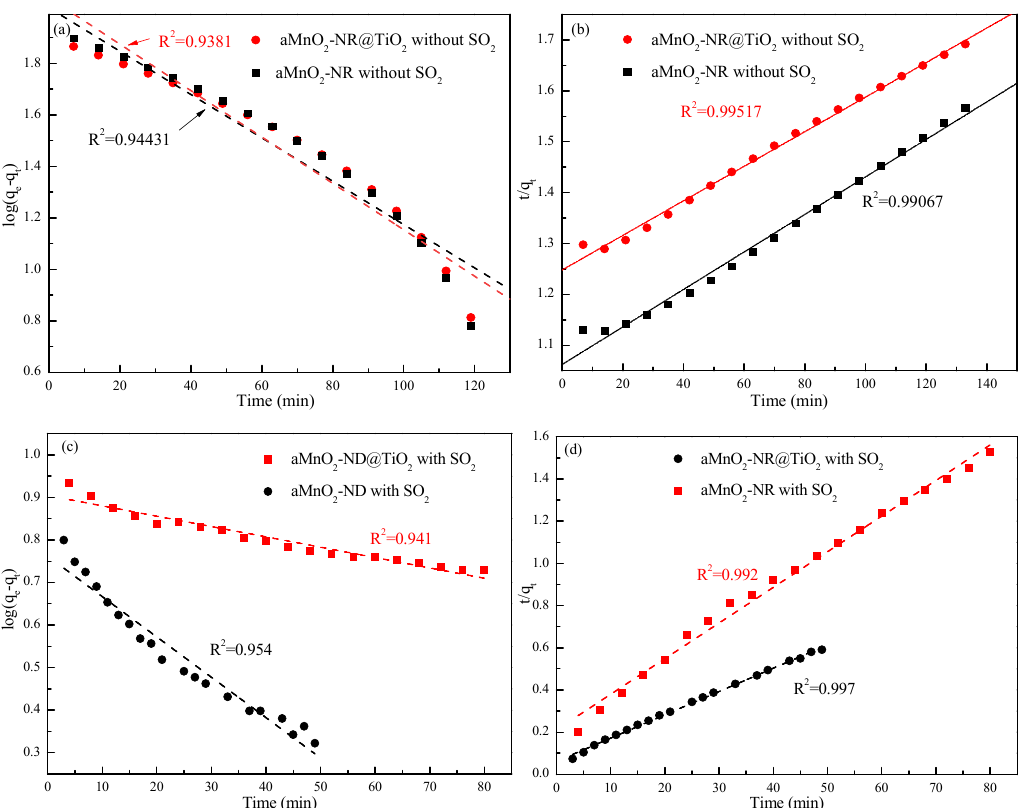
Figure 8. Kinetic analysis of Hg 0 adsorption on α MnO 2 -NR and α MnO 2 -NR@TiO 2 ( a ) pseudo-first order kinetic model without SO 2 , ( b ) pseudo-second order kinetic model without SO 2 , ( c ) pseudo-first order kinetic model with SO 2 , ( d ) pseudo-second order kinetic model with SO 2 . Table 2. Kinetic parameters (R 2 ) of pseudo-first order and pseudo-second order models. αMnO 2 -NR Kinetic Models